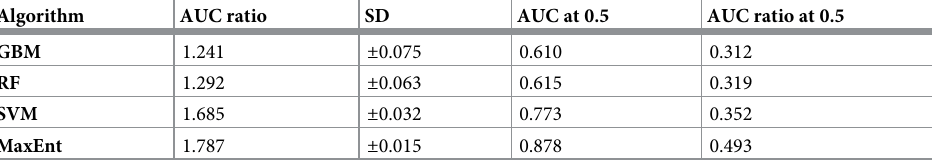
Table 2. Validation by calculating the partial ROC of models generated by four algorithms used. Area under the curve (AUC) and Standard deviation (SD) values are showed for each algorithm.